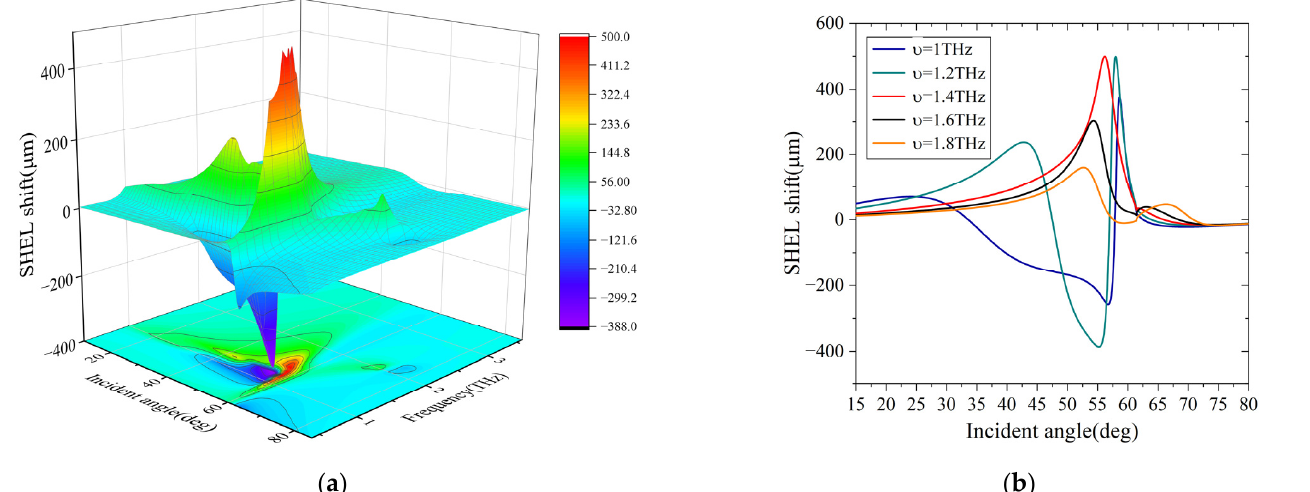
Figure 5. ( a ) Three-dimensional distribution of the beam centroid displacement of SHEL with the incident angle at different frequencies; ( b ) variation of SHEL shift with the incident angle at different frequencies.